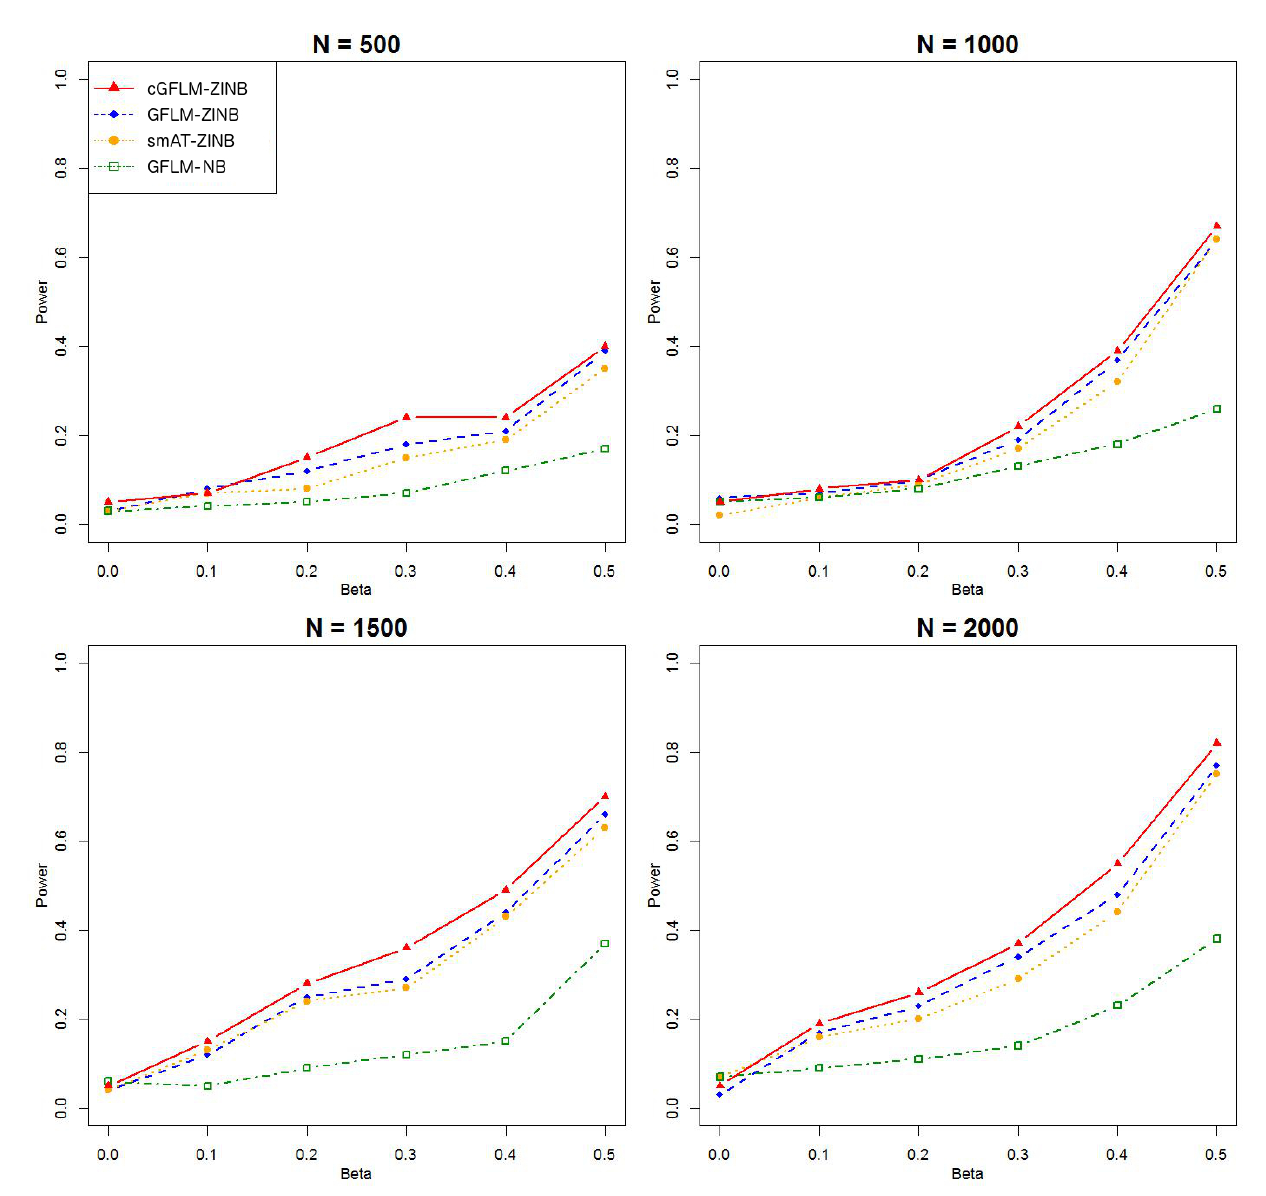
Figure A3. Power simulation for ZINB outcomes based on the CHRNA7 gene, single causal locus, effect in latent Bernoulli